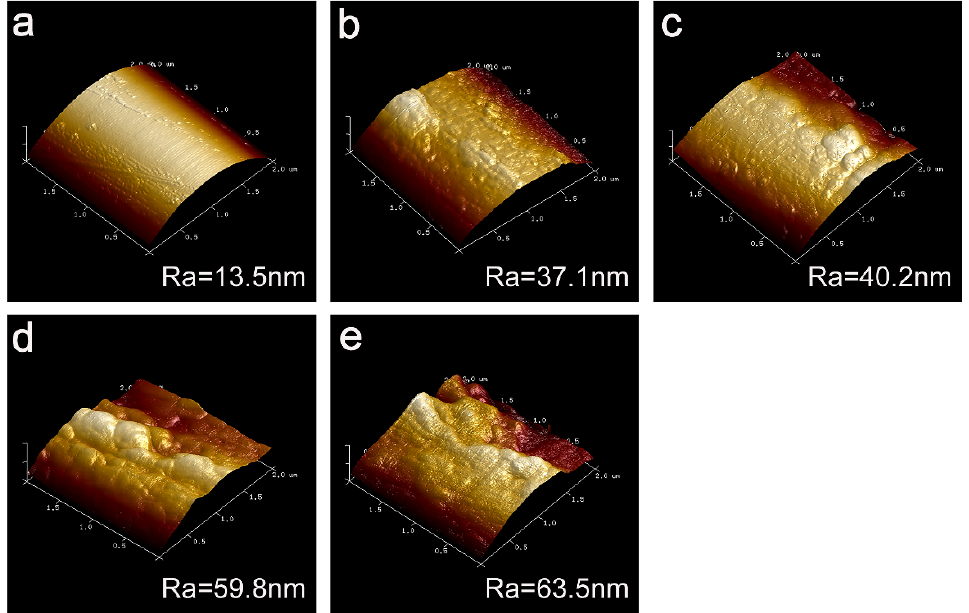
Figure 7. AFM images of carbon fibers ( a ) Untreated CF, ( b ) CF-KHN + , ( c ) CF-KHN + -2GO, ( d ) CF- KHN + -4GO, ( e ) CF-KHN + -6GO.